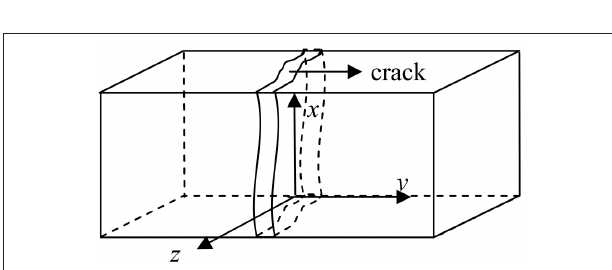
FIGURE 14 | Schematic diagram of cracking specimens.